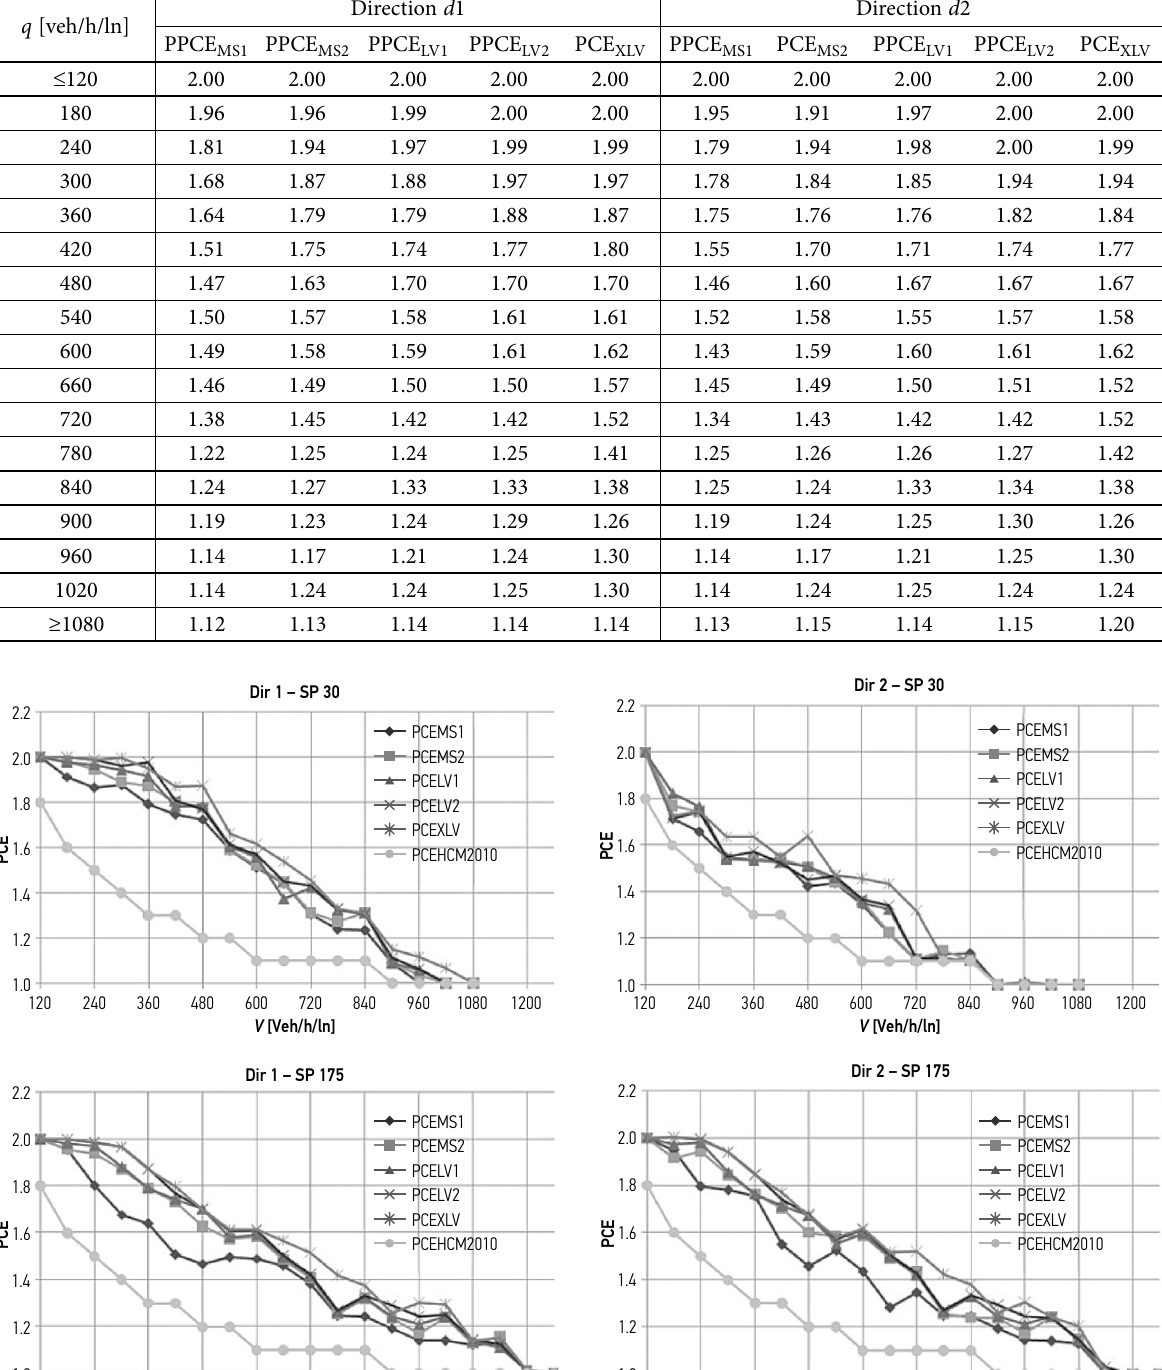
Table 4. PCE for SP175 road, directions d 1 and d